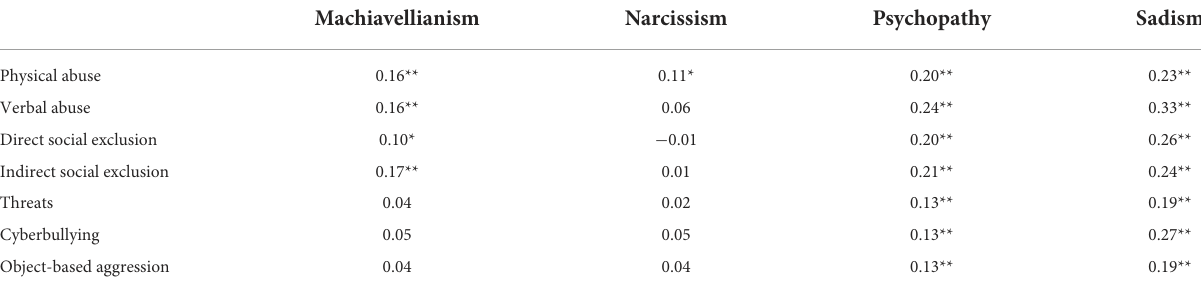
TABLE 2 Bivariate correlations between dark tetrad personality traits and seven types of bullying victimization